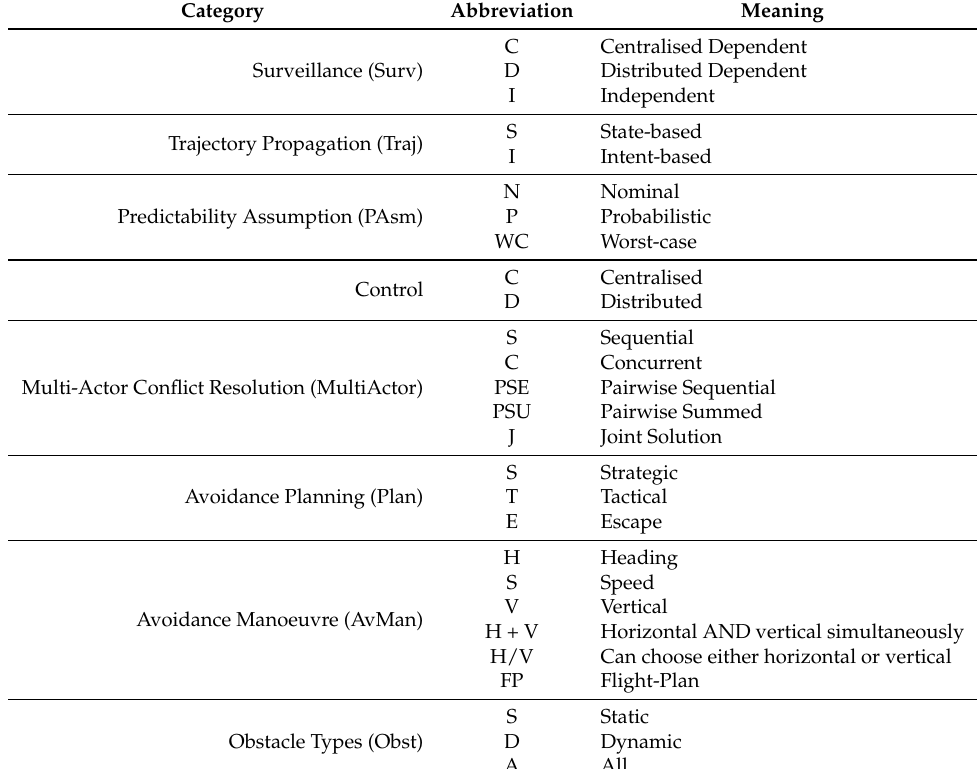
Table 5. Used abbreviations for the Conflict Detection and Resolution (CD&R) categories displayed in Tables 3 and